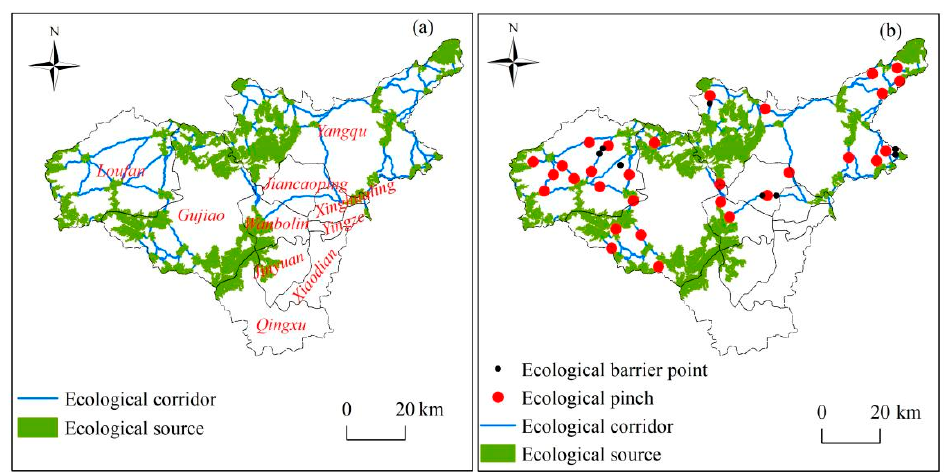
Figure 9. ( a ) Ecological corridors in Taiyuan City and ( b ) ecological pinch and barrier point construc- tion in Taiyuan City.